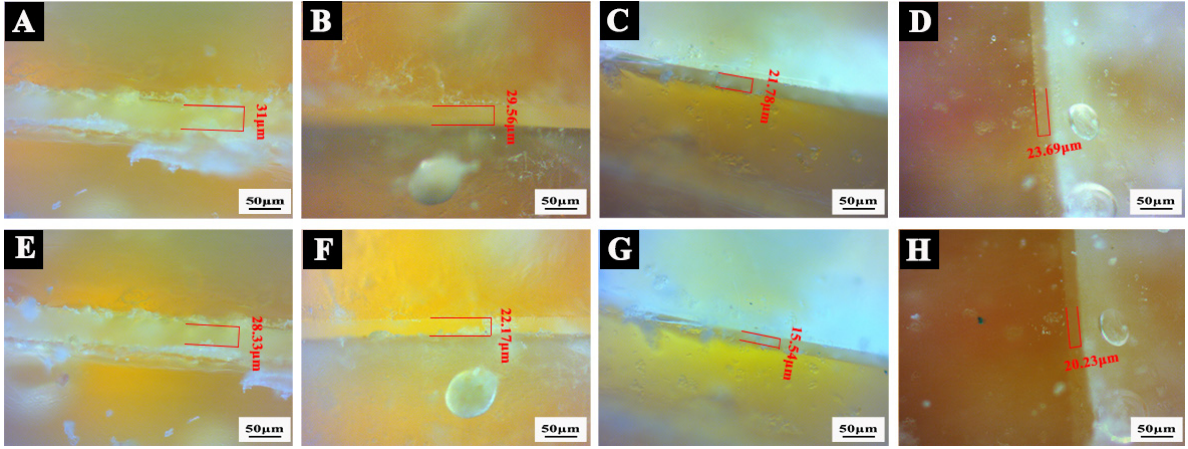
Figure 15. OM of scratch repair results of surface coatings on Beli wood loaded with 3.0 wt.% different shellac microcapsules: ( A ) damaged pure waterborne coating, ( B ) damaged waterborne coating containing transparent shellac microcapsules, ( C ) damaged waterborne coating containing purple shellac microcapsules, ( D ) damaged waterborne coating containing yellow shellac microcapsules, ( E ) damaged pure waterborne coating after 5 d, ( F ) damaged waterborne coating containing transparent shellac microcapsules after 5 d, ( G ) damaged waterborne coating containing purple shellac microcapsules after 5 d, ( H ) damaged waterborne coating containing yellow shellac microcapsules after 5 d.